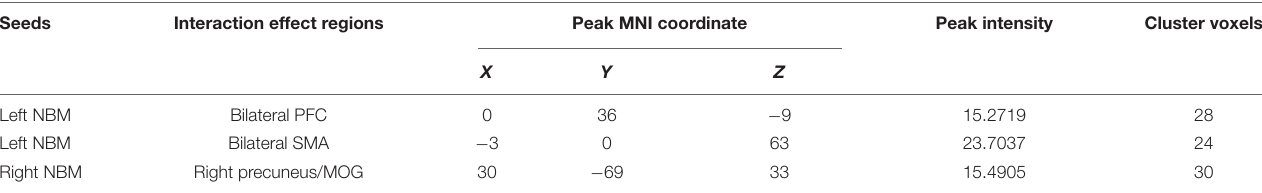
TABLE 2 | Condition × diagnosis interaction on rsFC of the NBM after PSM.